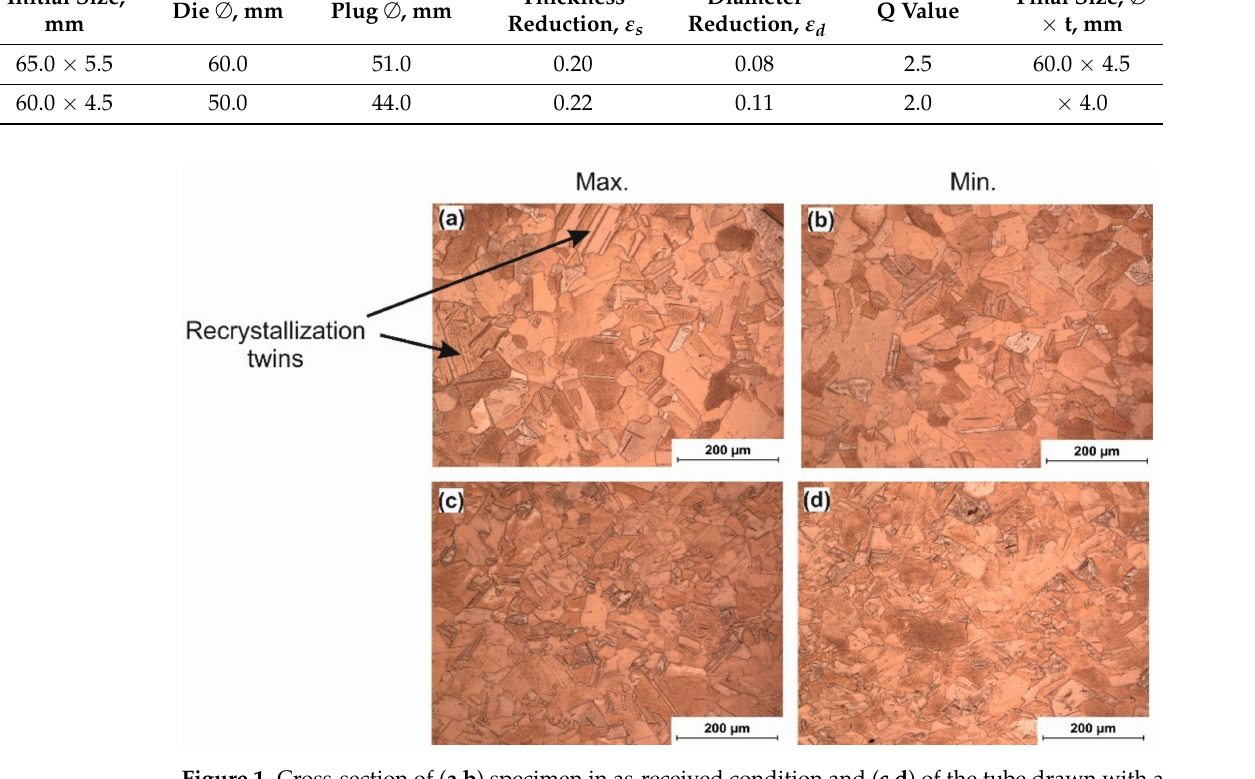
Figure 1. Cross-section of ( a , b ) specimen in as-received condition and ( c , d ) of the tube drawn with a tilt angle of − 5 ◦ in the max and min